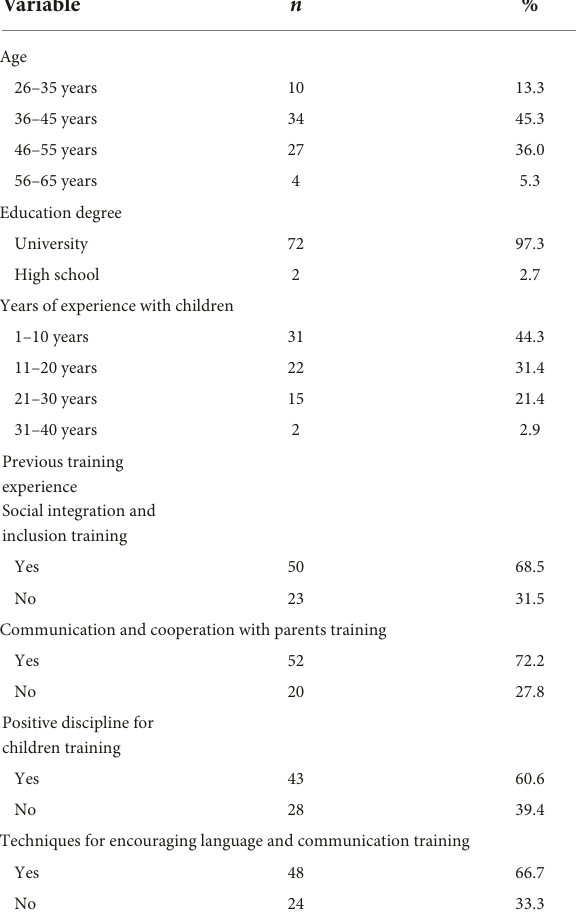
TABLE 1 Demographic and professional characteristics of participants ( N =